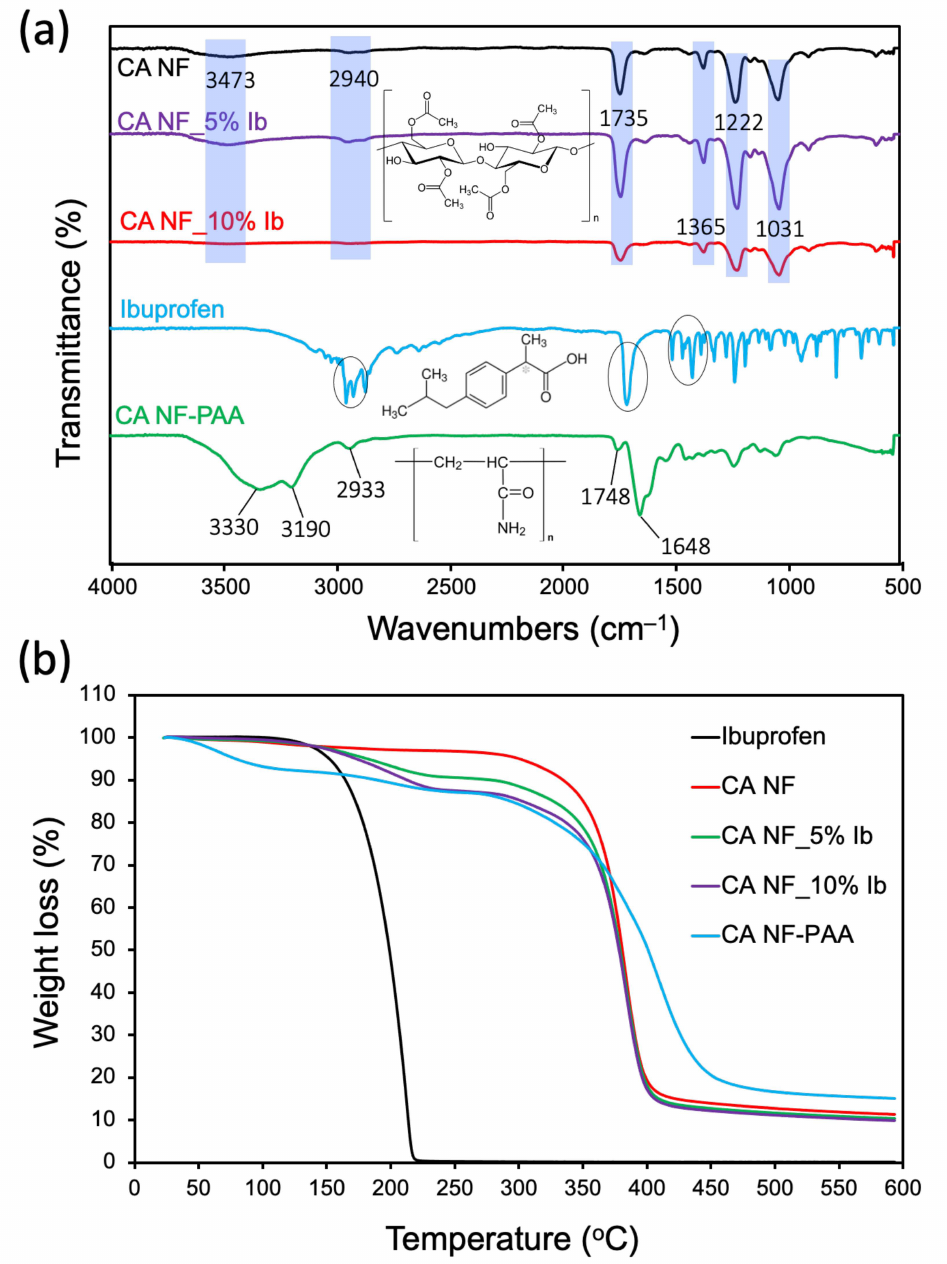
Figure 2. ( a ) FTIR spectra analyzed between 4000 and 500 cm − 1 and ( b ) TGA analysis for all formulated nanofibers including unmodified CANF, CANF loaded with 5 and 10 wt.% ibuprofen and drug-loaded CANFs coated with poly-AAm